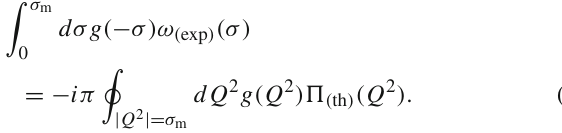
Fig. 2 The spectral function ω(σ) for the (V+A)-channel, measured by ALEPH Collaboration [1,3–5], without the pion peak. The pion peak contribution 2 π 2 f 2 π δ(σ − m 2 π ) has to be added (where we took f π = 0 . 1305 GeV). In the sum rules we will take σ m = 2 . 80 GeV 2